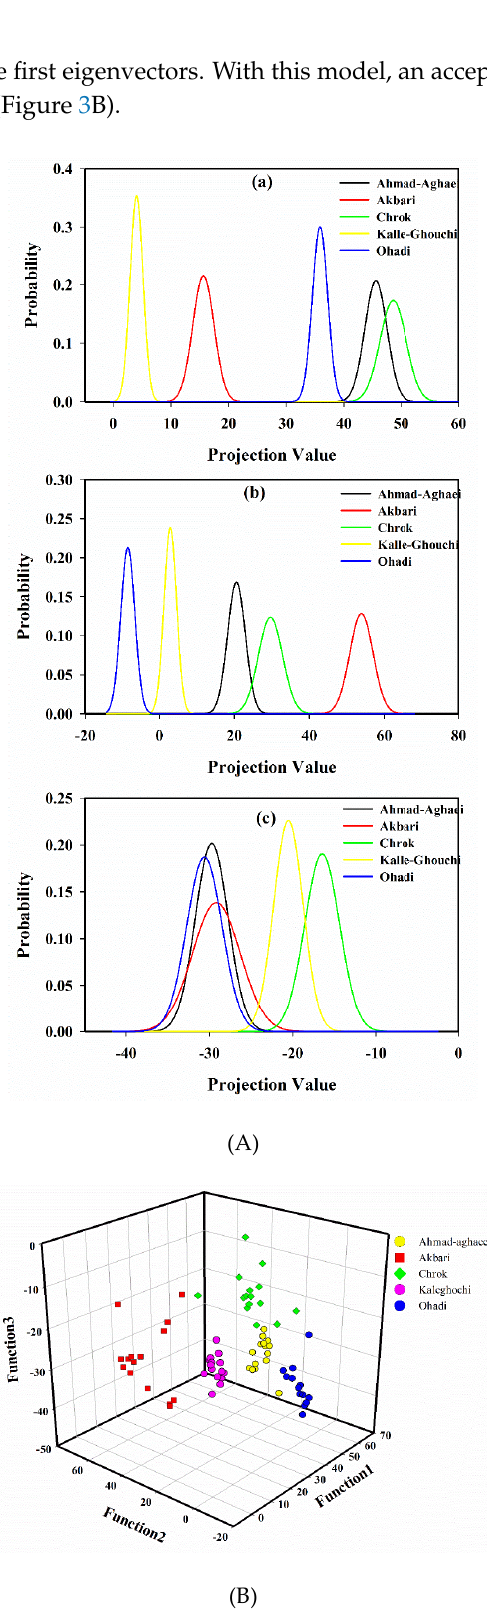
Figure 3. The probability density function of projected points of the peak areas from the fatty acid fingerprints by linear discriminant analysis using the ( a ) first, ( b ) second, and ( c ) third projection vector ( A ), and scatter plot of the calibration samples in 3D space defined by the three discriminant functions of the LDA model, which was constructed to classify pistachio samples according to their cultivar ( B